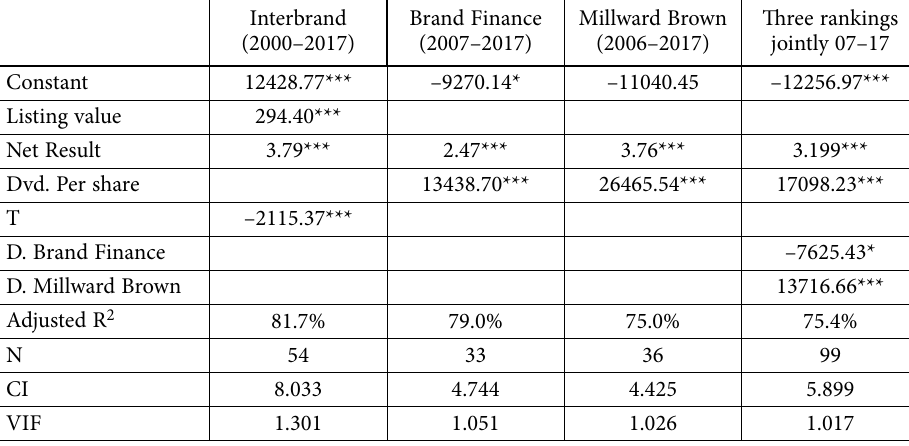
Table 7. The linear regression results for the high-value brands of the Software